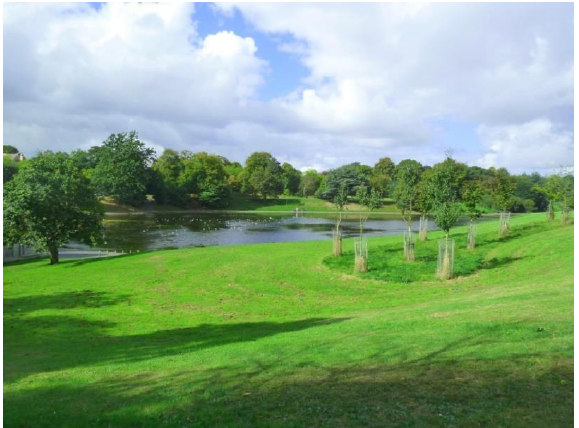
Figure 2. Example of green spaces promoting respect and social inclusion (P1) (Sefton Park, Liverpool).